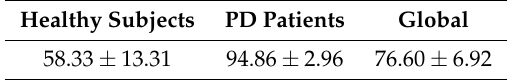
Table 8. Recognition rates per class and global accuracy ( mean ± sd ) obtained by the best-evolved